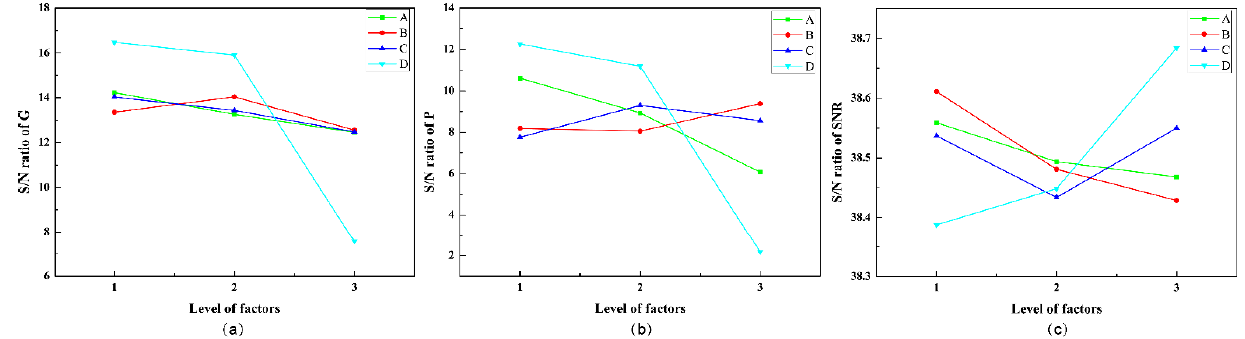
Figure 4. S/N ratio of the different characteristics. ( a ) S/N ratio of the G at different levels; ( b ) S/N ratio of the P at different levels; ( c ) S/N ratio of the SNR at different levels.